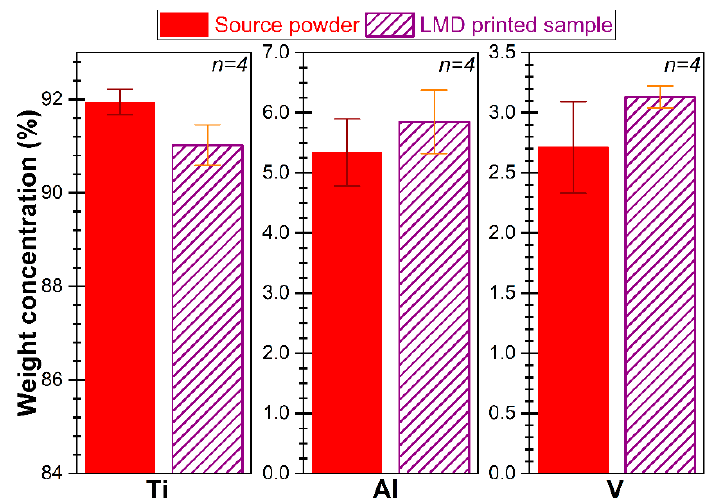
Figure 8. Comparative concentrations for Ti, Al, and V estimated by EDXS for the source powder and solid structure printed by LMD.